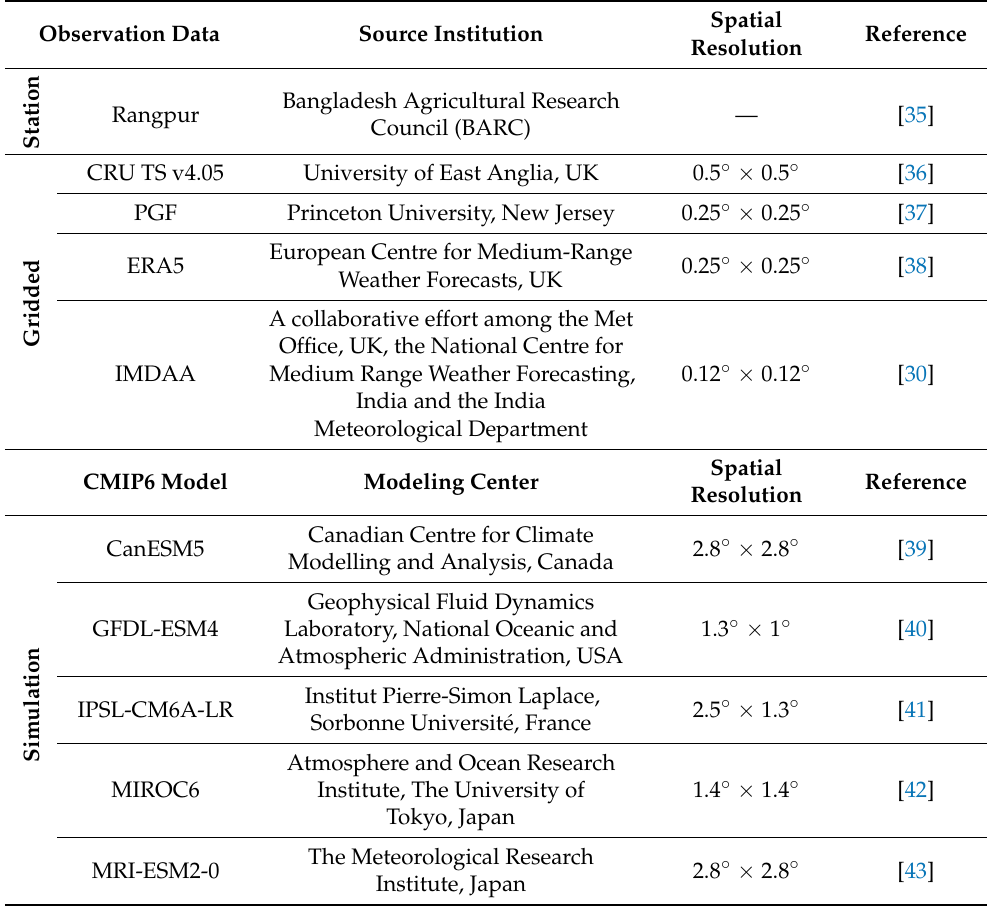
Table 2. Details of the observation and simulation data used in this